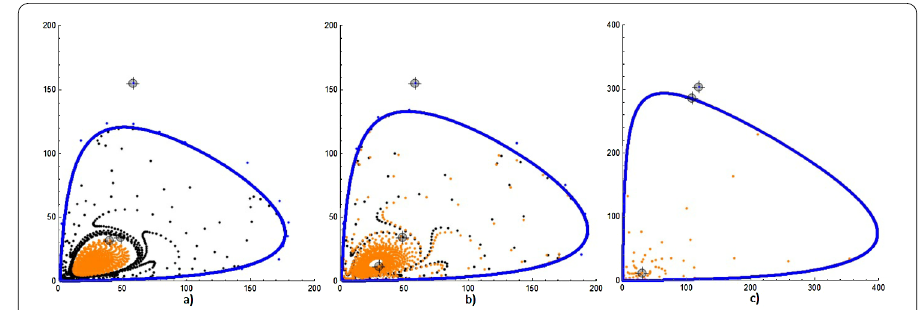
Figure 5 Subcritical Neimark–Sacker bifurcation for b = 0.87, m = 2.76, d = 0.126317, where a 0 = 2.8, d 2 ( a 0 ) ≈ 0.0502817, and α 2 ( a 0 ) ≈ 0.0000434287. Trajectories (orange, blue, and black) for ( a ) a = 2.75, ( b ) b = 2.8, and ( c ) a = 3.5 for model